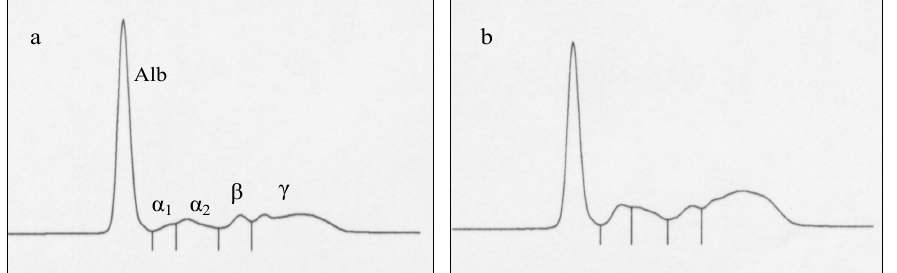
Figure 4. Results of protein electrophoresis of representative sera derived from ( a ) one cow from the high-AMH group (A/G ratio: 2.9) and ( b ) one cow from the low-AMH group (A/G ratio: 0.5) at D28. Alb: Albumin; α 1 : α 1 -globulin; α 2 : α 2 -globulin; β : β -globulin; γ : γ